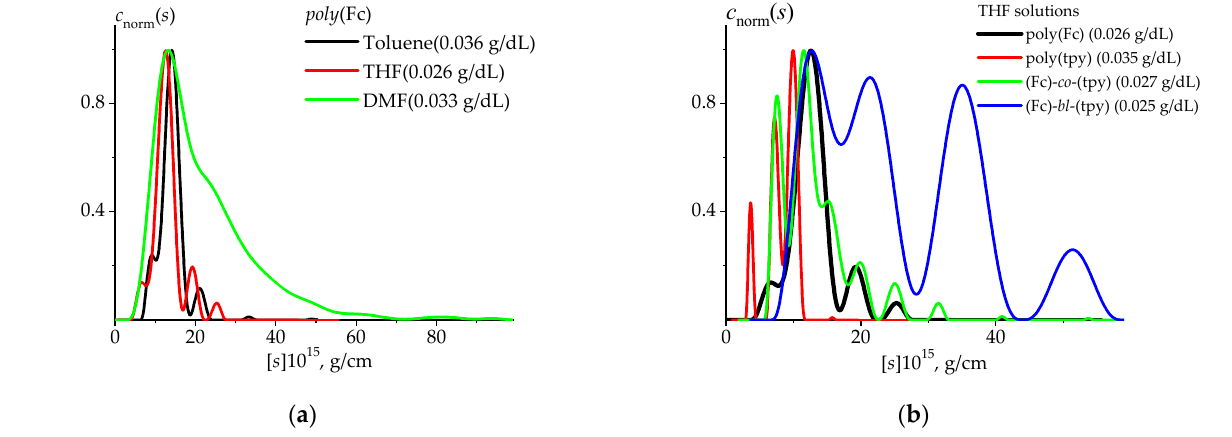
Figure 4. Normalized c ( s ) distributions vs. intrinsic sedimentation coefficients [ s ] resolved with Sedfit for the poly (Fc) sample in different solvents ( a ) and all of the studied polymers in THF solutions ( b ). The presented distributions correspond to the lowest studied concentration of the systems, and the concentration values are indicated in the figure. All AUC runs were performed at 20 °C.